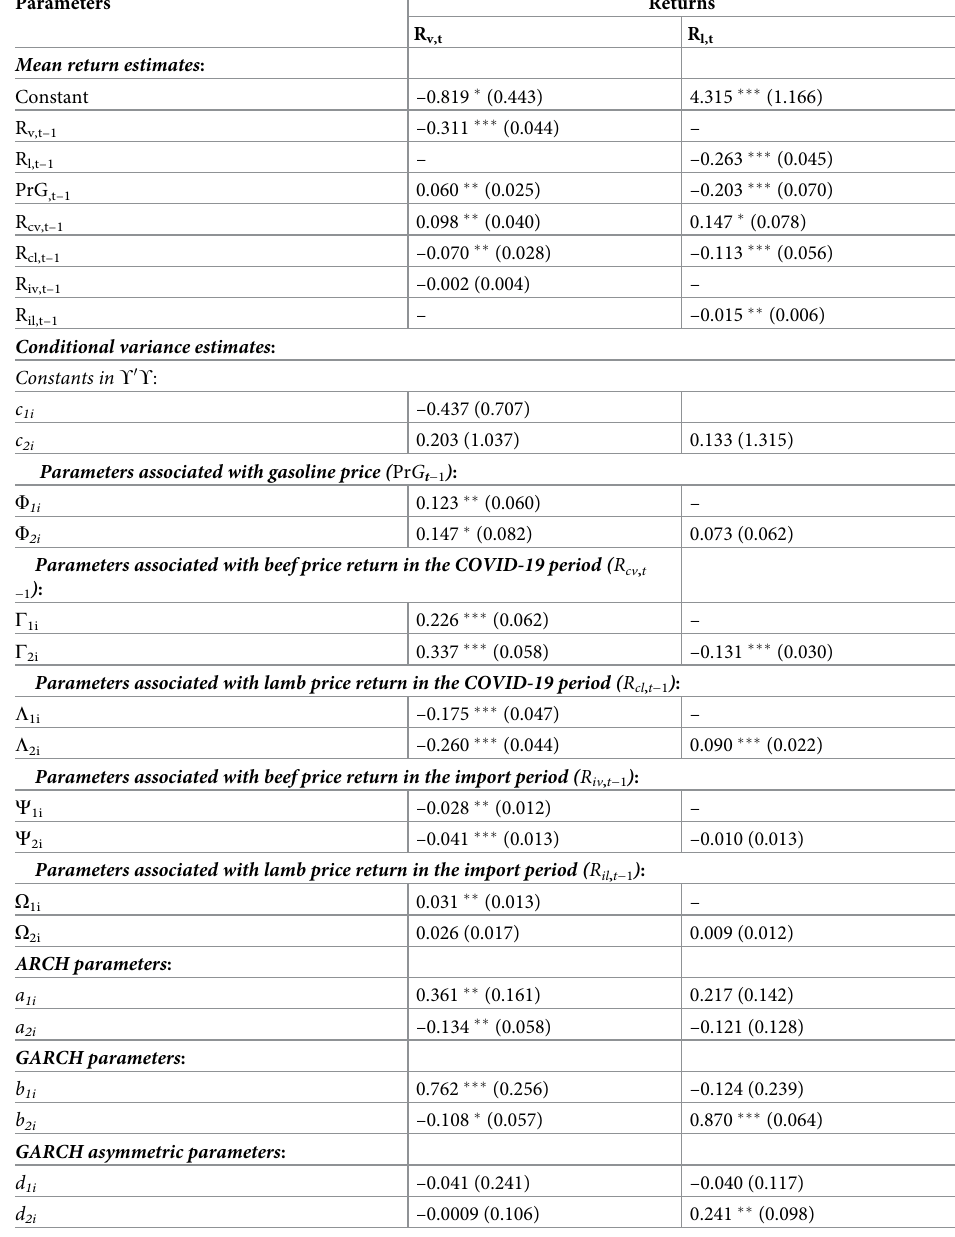
Table 3. Parameter estimates for both mean returns and conditional